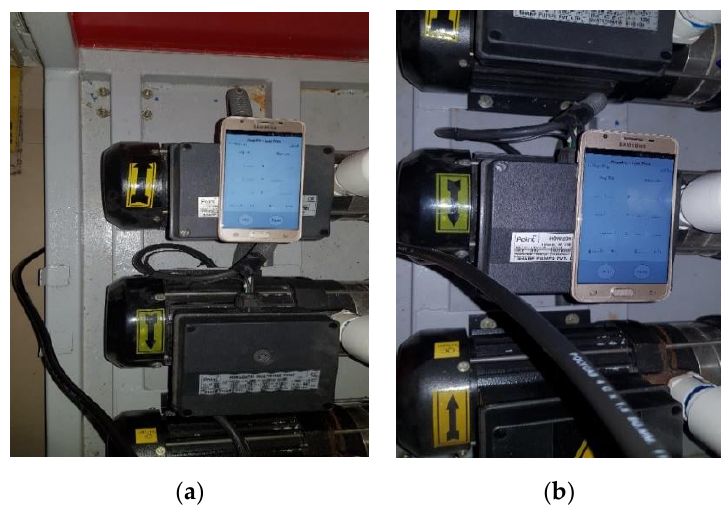
Figure 10. ( a ) Mobile-based app-connected to the pump motor, ( b ) Vib Sensor mobile-based app.